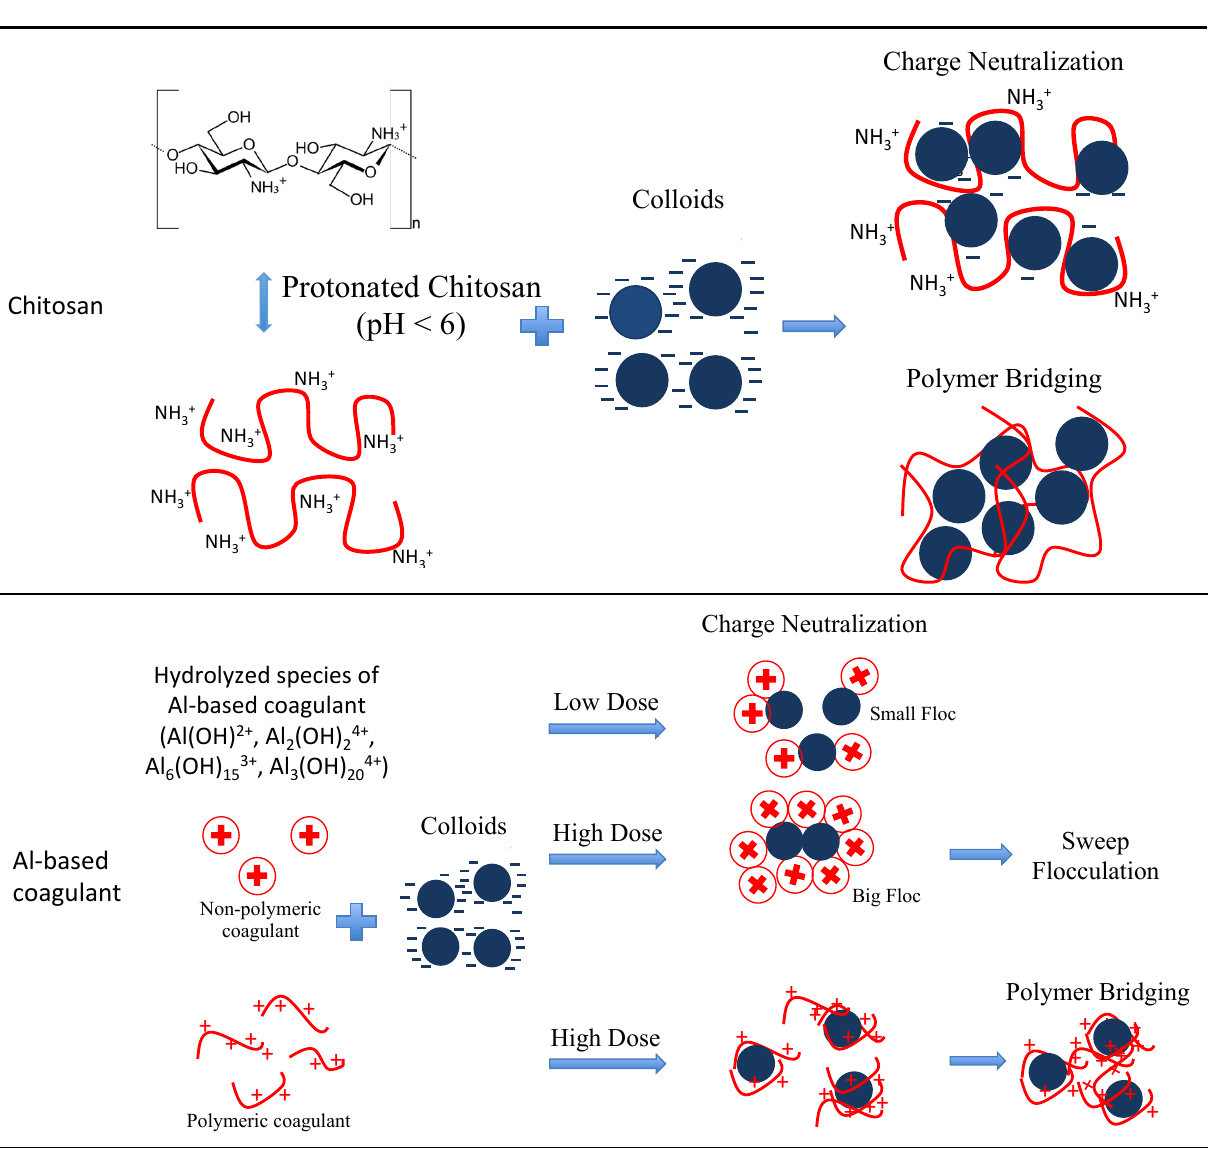
Figure 2. Illustration of coagulation–flocculation mechanisms of chitosan and Al-based coagulants (non-polymeric and polymeric coagulant)